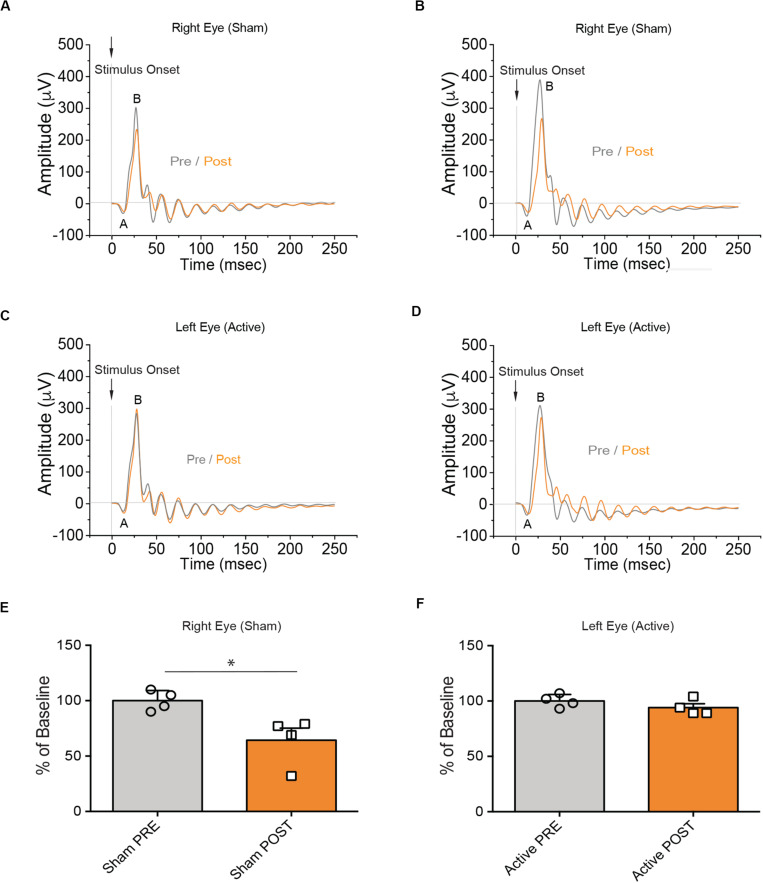
Electroretinographic responses in naïve pigs subretinally implanted with the PET-based prosthesis. (A,B) Representative ff-ERG signals of the right eye of the E31 (left) and E34 (right) pigs before surgery (Pre, gray) and after (Post, orange) implantation of the sham PET substrate alone. (C,D) Representative ff-ERG signals of the left eye of the E31 (left) and E34 (right) pigs before surgery (Pre, gray) and after (Post, orange) implantation of the PET-based complete polymeric device (active). (E,F) Bar plots (mean ± SD) depicting the amplitude of the ff-ERGs b-wave before (Pre, gray) and after (Post, orange) the implantation of either sham substrate (right eye; E) or the active device (left eye; F) in n = 4 individual pigs. Data (means ± SD with superimposed experimental points) are expressed as the percentage of baseline. Before the surgical intervention, the amplitude of the ff-ERG b-wave in the eyes of all pigs was normal. Notably, these signals were preserved after the subretinal implantation of the PET-based active prosthetics in all animals (p = 0.1492). No rescue effect was observed in sham-implanted animals (p = 0.0182). ∗p < 0.05, paired Student’s t-test (n = 4).